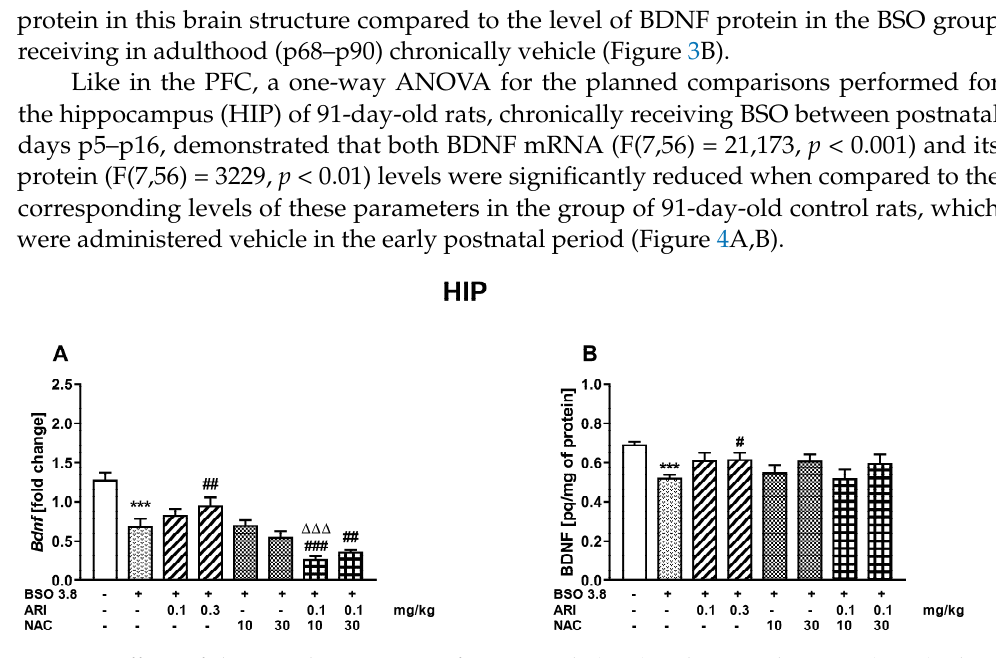
Figure 4. Effects of chronic administration of aripiprazole (ARI) and N-acetylcysteine (NAC), alone or in combination, on BDNF mRNA ( A ) and protein ( B ) levels in the hippocampus of adult 91-day-old Sprague–Dawley rats that received chronic BSO during early postnatal life (P5-P16). Data are presented as the mean ± SEM, n = 8 for each group. Statistical analysis was performed using a one-way ANOVA for the planned comparisons; symbols indicate significance of differences between the tested groups, *** p < 0.001 vs. control vehicle-treated group; ### p < 0.001, ## p < 0.01, # p < 0.05 vs. BSO-treated group; ΔΔΔ p < 0.001 vs. BSO + NAC (10 mg/kg)-treated group.